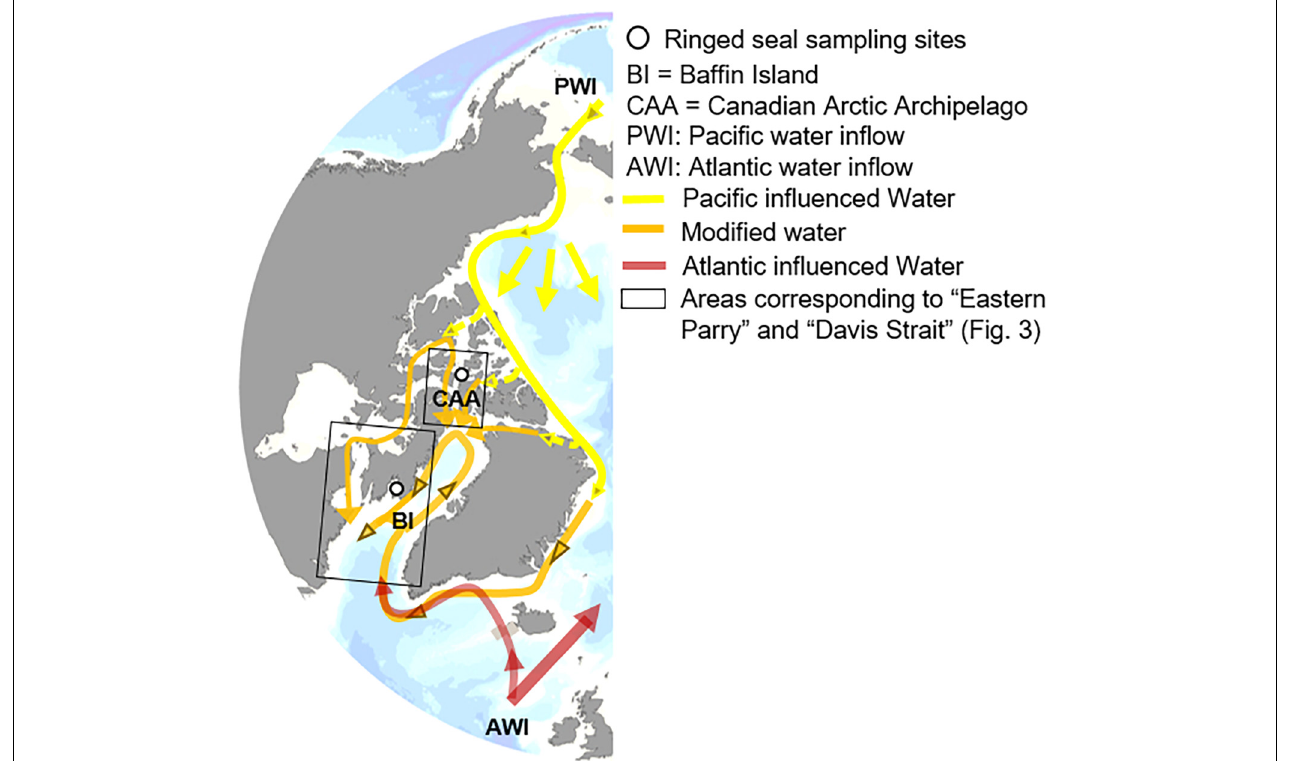
FIGURE 1 | Map depicting the seal sampling sites and main Arctic circulation.